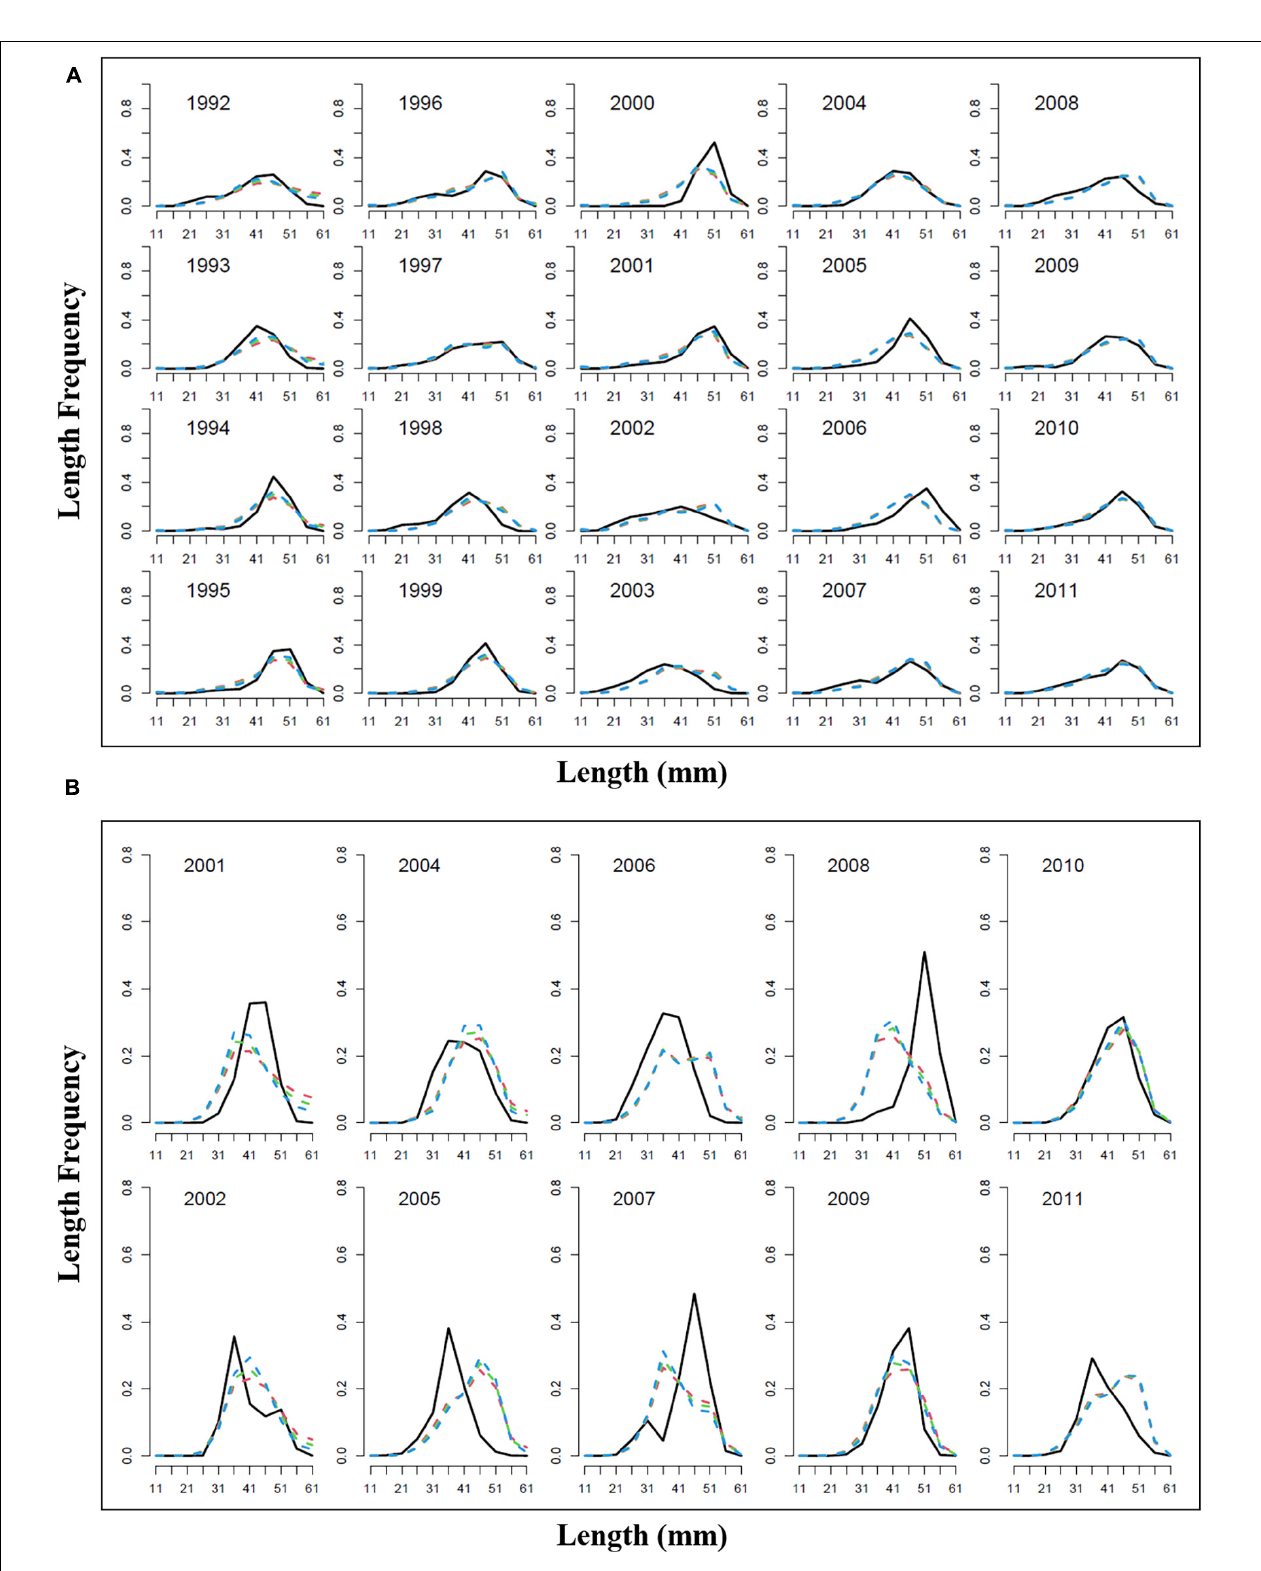
FIGURE 4 | Observed length frequency length (black solid line) and predicted length frequency (dotted red line present weights in 0.25, dotted green line present weight in 0.5, dotted blue line present weight in 1); (A) survey length frequency; (B) catch length frequency.